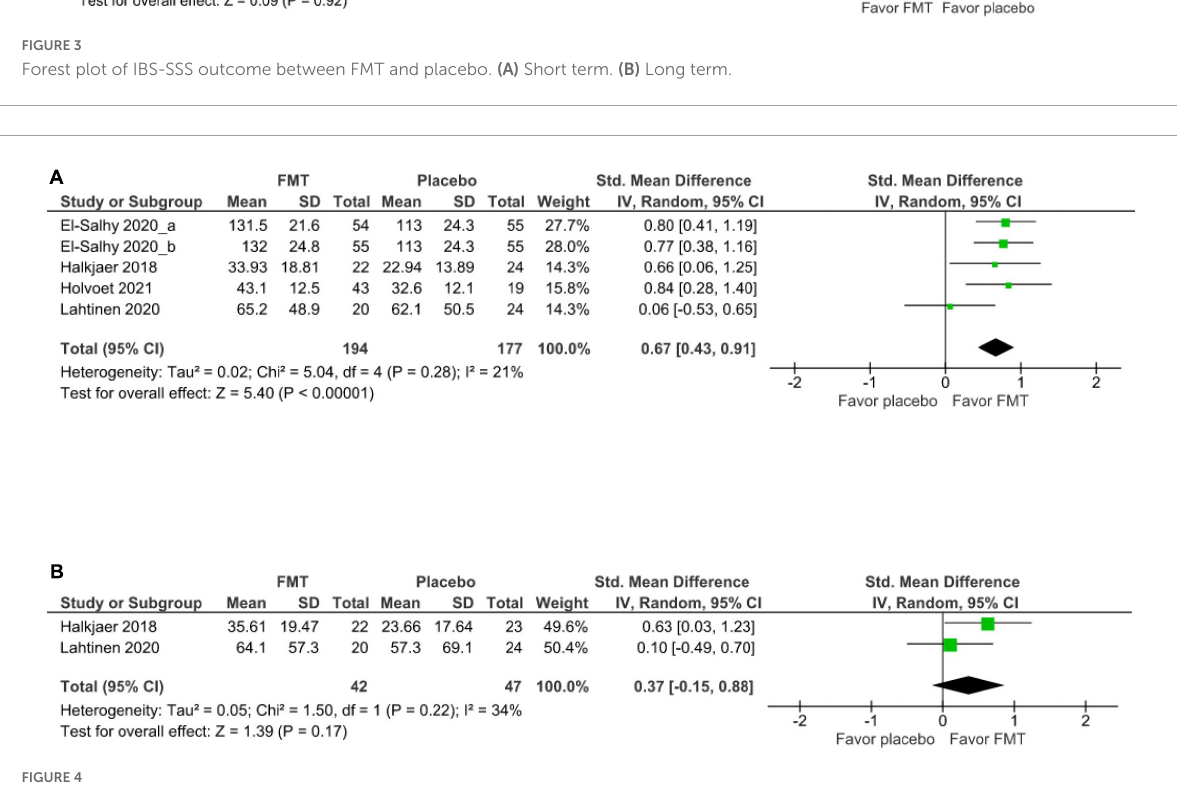
FIGURE4 Forest plot of IBS-QoL outcome between FMT and placebo. (A) Short term. (B) Long